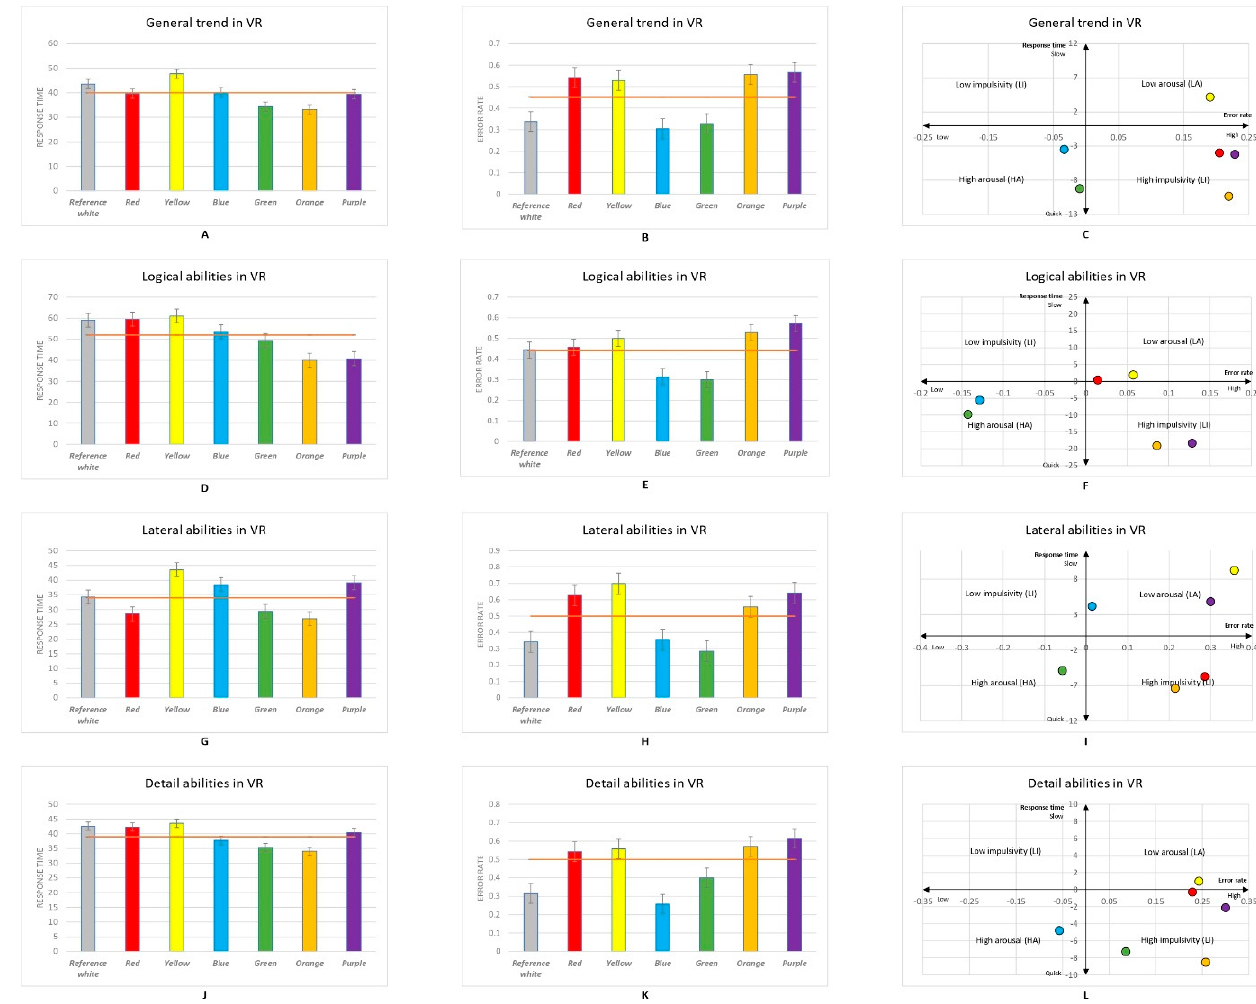
Figure 3. ( A ) General trend of response time by background colour in virtual reality (VR); ( B ) general trend of error rate by background colour in VR; ( C ) colour impacts on general performance in VR visualised in the Error–Speed space; ( D ) response time of participants’ performance in logical abilities by background colour in VR calculated in seconds; ( E ) error rate of participants’ performance in logical abilities by background colour in VR; ( F ) colour impacts on logical abilities in VR visualised in the Error–Speed space; ( G ) response time of participants’ performance in lateral thinking abilities by background colour in VR; ( H ) error rate of participants’ performance in lateral abilities by background colour in VR; ( I ) colour impacts on lateral thinking abilities in VR visualised in the Error–Speed space; ( J ) response time of participants’ performance in detail abilities by background colour in VR; ( K ) error rate of participants’ performance in detail abilities by background colour in VR; ( L ) colour impacts on detail abilities in VR visualised in the Error–Speed space. The bars represent mean changes, while the error bars are the standard error of the mean across individual participants. People’s responses to the reference white background are located on the centre axis in figures ( C , F , I , L ). Figure 3D,E display the impact of colour in VR on logical ability. Participants reacted fastest when viewing the orange background and slowest when viewing the yellow back- ground. Significant differences in response time were found between green and yellow ( p = 0.017), orange ( p = 0.007), and purple ( p = 0.001) backgrounds, as well as between blue and yellow ( p = 0.027), orange ( p = 0.011), and purple ( p = 0.002) backgrounds. Figure 3E shows that viewing the green background led to the lowest error rate, while viewing the purple background led to the highest error rate. The Kruskal–Wallis test indicated significant differences between the blue and purple ( p = 0.002), orange ( p = 0.011),